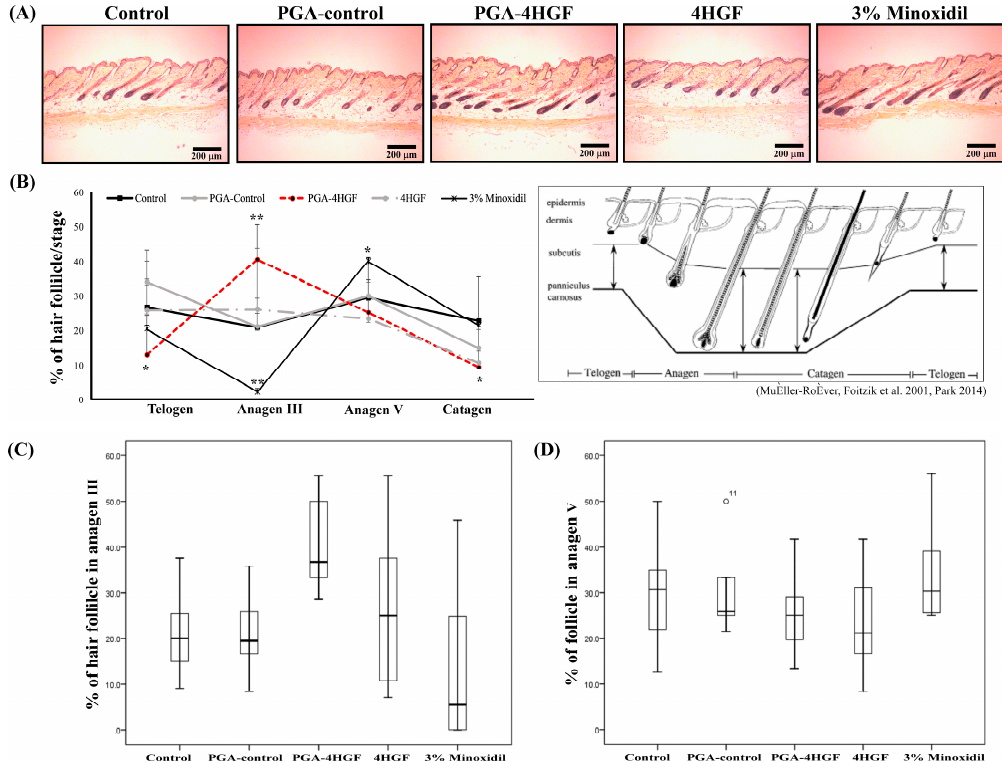
Figure 5. Early induction of the anagen phase by PGA- 4HGF treated in telogenic C57BL/6N mice. ( A ) The hair follicles in the longitudinal sections of the dorsal area were stained with H&E. Representative photomicrograph of the hair follicles in dorsal tissue treated with DW, PGA-control, PGA-4HGF, 4HGF, or 3% minoxidil for 12 days (200× magnification, scale bars: 200 μ m). ( B ) Quantitative histomorphometric analysis. The percentage of the hair follicles in each hair cycle stage at 12 days was calculated (%: (number of hair follicles in each hair cycle/number of total hair follicles) × 100). Values data represent means ± standard error (SE). Data were analyzed with one-way ANOVA/Dunnett’s t -test (* p < 0.05, ** p < 0.01 vs the control group). Box-plot shows the % of hair follicle in anagen III ( C ) and the % of hair follicle in anagen V ( D ). The full line represents median values. Also shown are 10, 25, 75 and